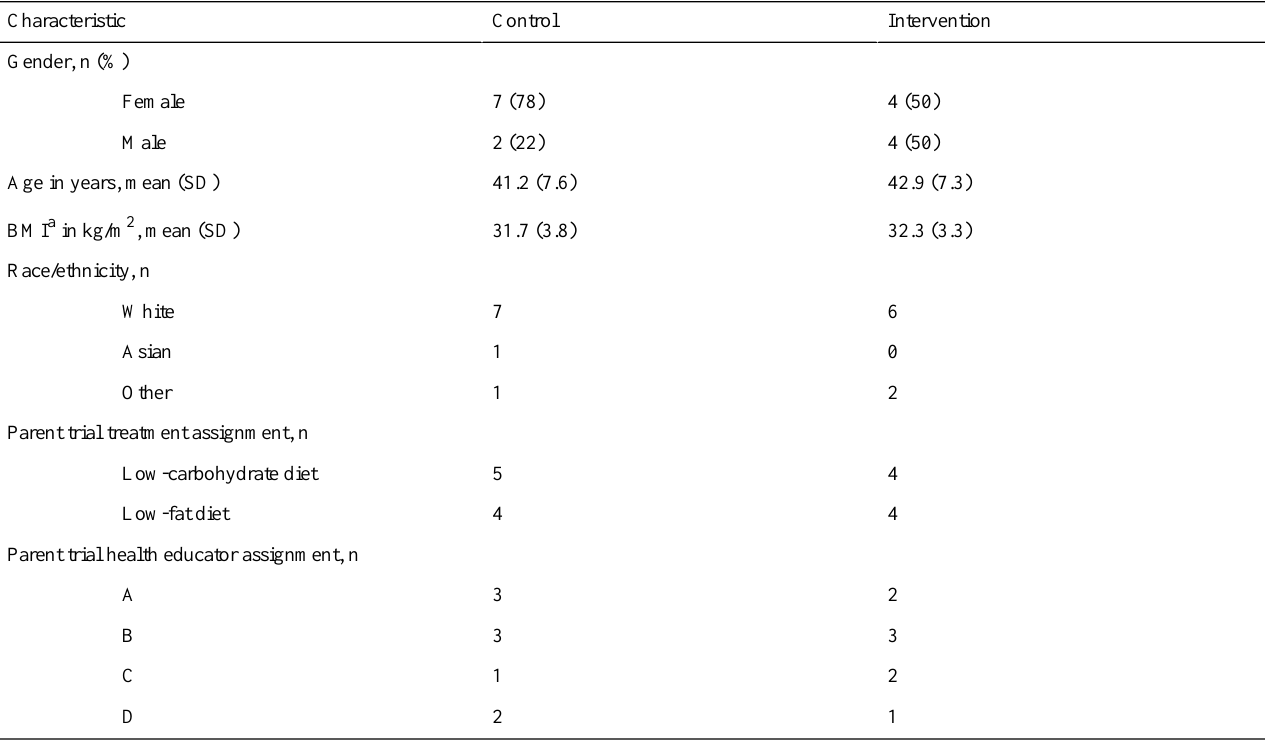
Table 1. Participant baseline characteristics.